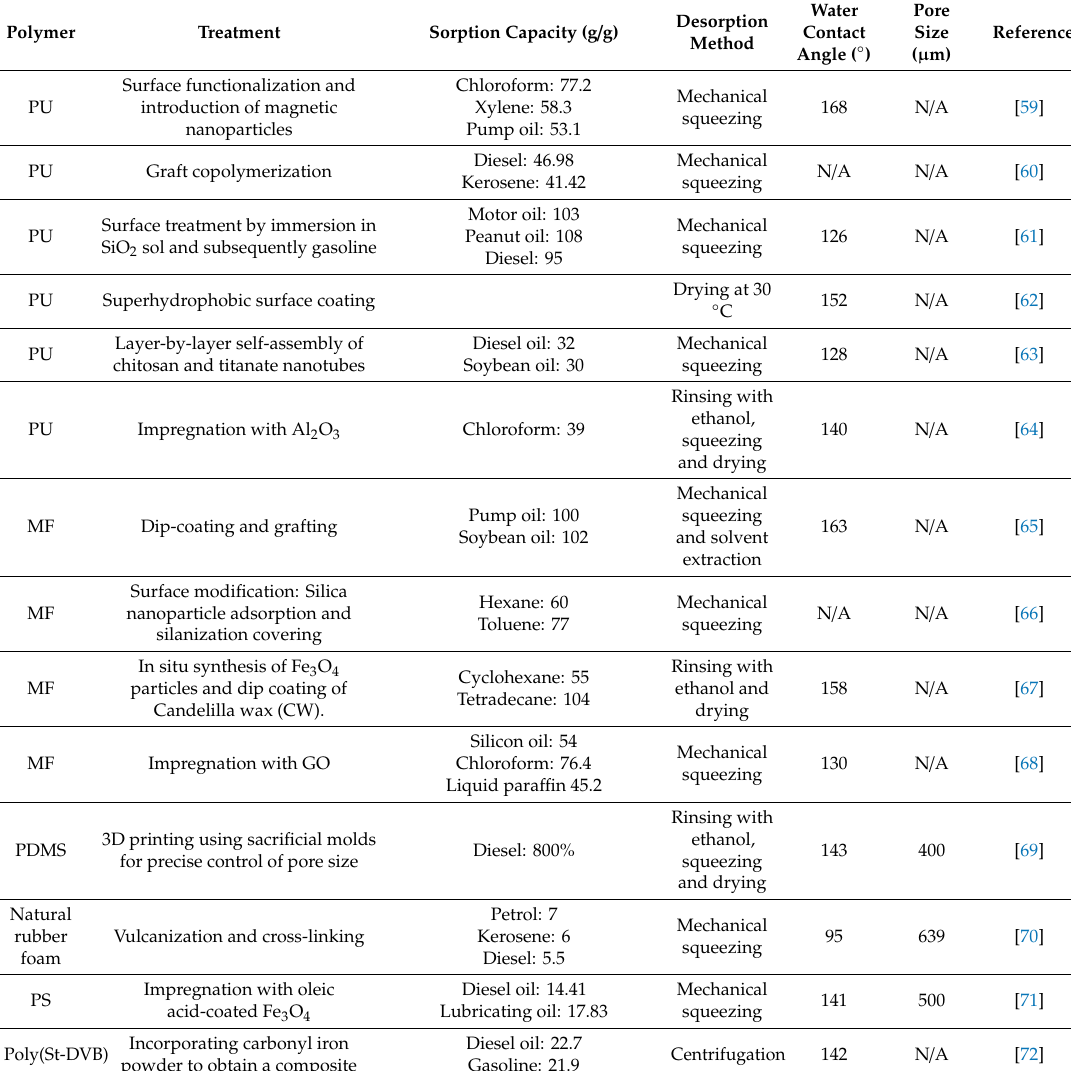
Table 3. Studies devoted to sorption materials based on polymeric